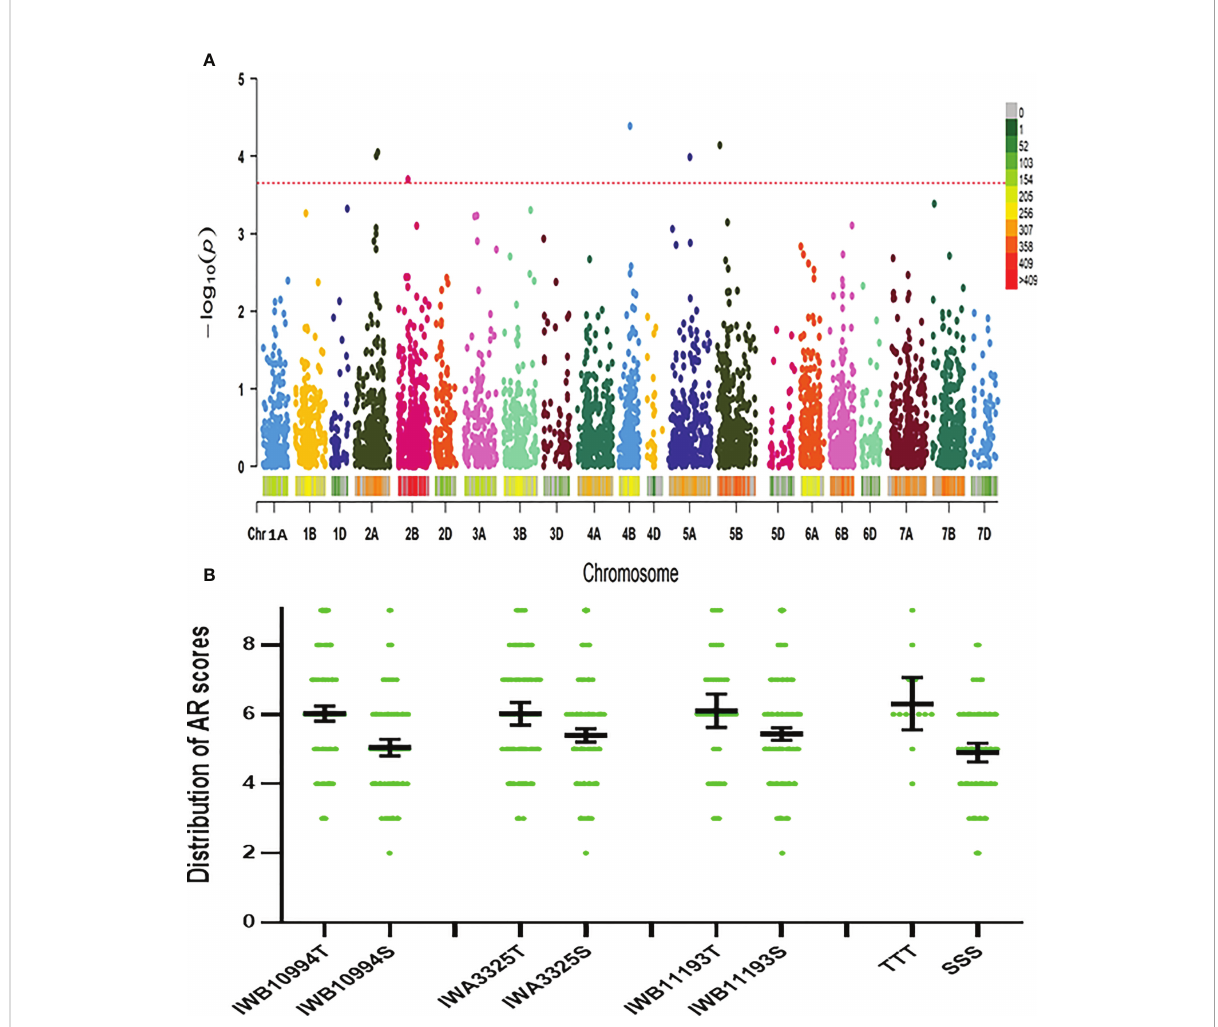
FIGURE 5 Marker-trait (root survival) associations. (A) : GWAS for root survival using FarmCPU: Lod values of all the markers; (B) : distribution of root survival scores of genotypes with three markers signi fi cantly correlated with root survival and the combination of all three markers. T, tolerance allele; S, sensitive allele; TTT, tolerance alleles of all three markers; SSS, sensitive alleles of all three